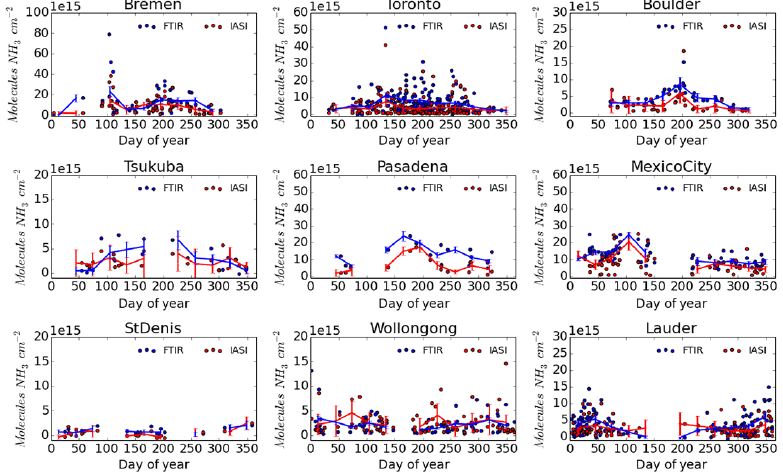
Figure 4. Time series of NH 3 for IASI and FTIR datasets with x diff < 25km and t diff < 90min (FTIR: blue and IASI: red). Scattered values are the observations for each day of year (multiple years of observations). The lines show the monthly mean total columns of the respective